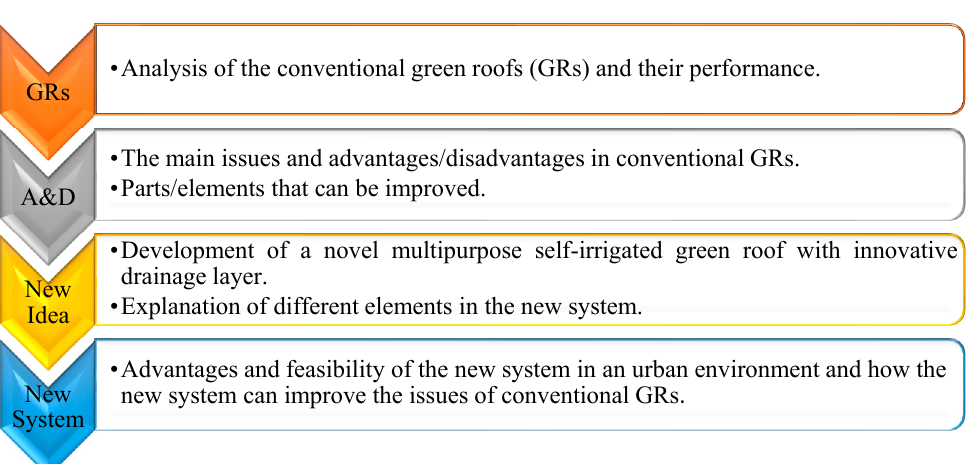
Figure 1. Research analysis diagram.